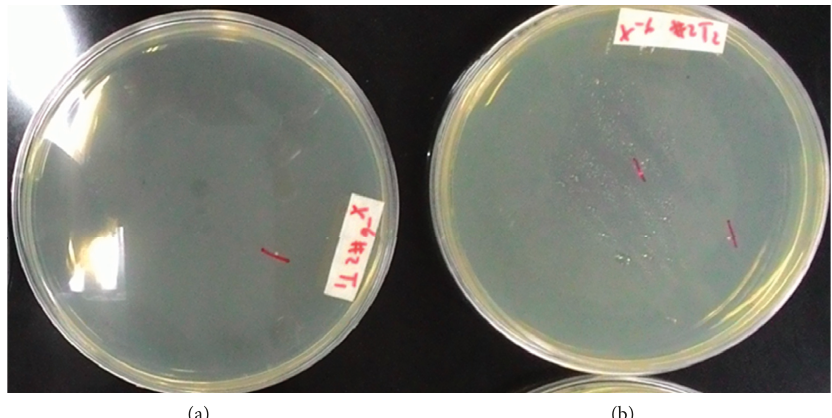
6 grown (a) with and (b) without the Ag/TiO −